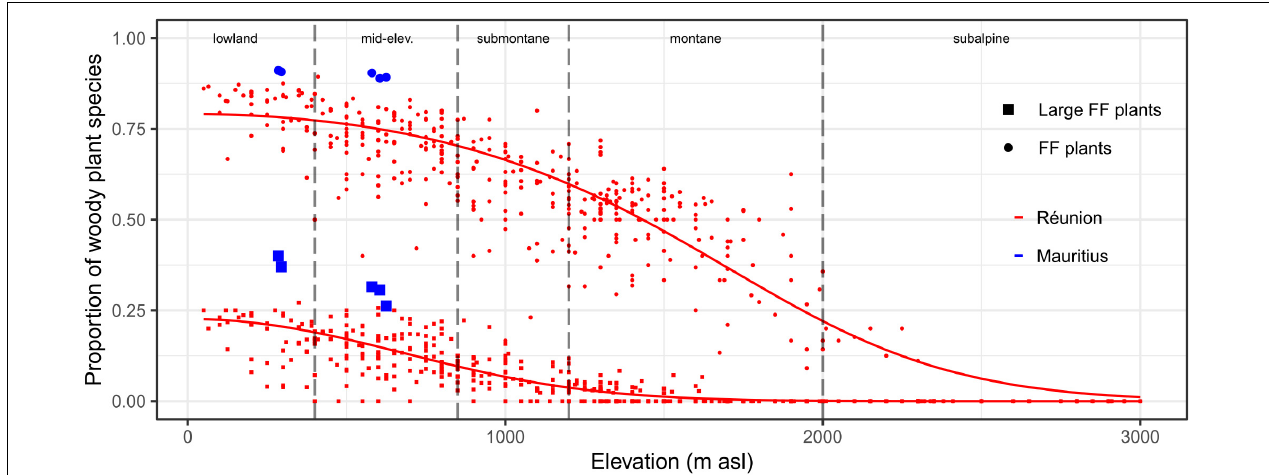
FIGURE 3 | Proportion of (large) fleshy-fruited plants within woody plant communities depending on elevation on Réunion and Mauritius. The x-axis is divided according to the typology of elevational habitats (dashed vertical lines). Dots and squares symbolize the proportions of fleshy-fruited (FF) and large fleshy-fruited plants, respectively. Sampling plots on Réunion and Mauritius are displayed by red and blue colors, respectively. For Réunion, predicted probabilities are displayed by solid lines (spatial modeling is visible at Supplementary Appendix 4